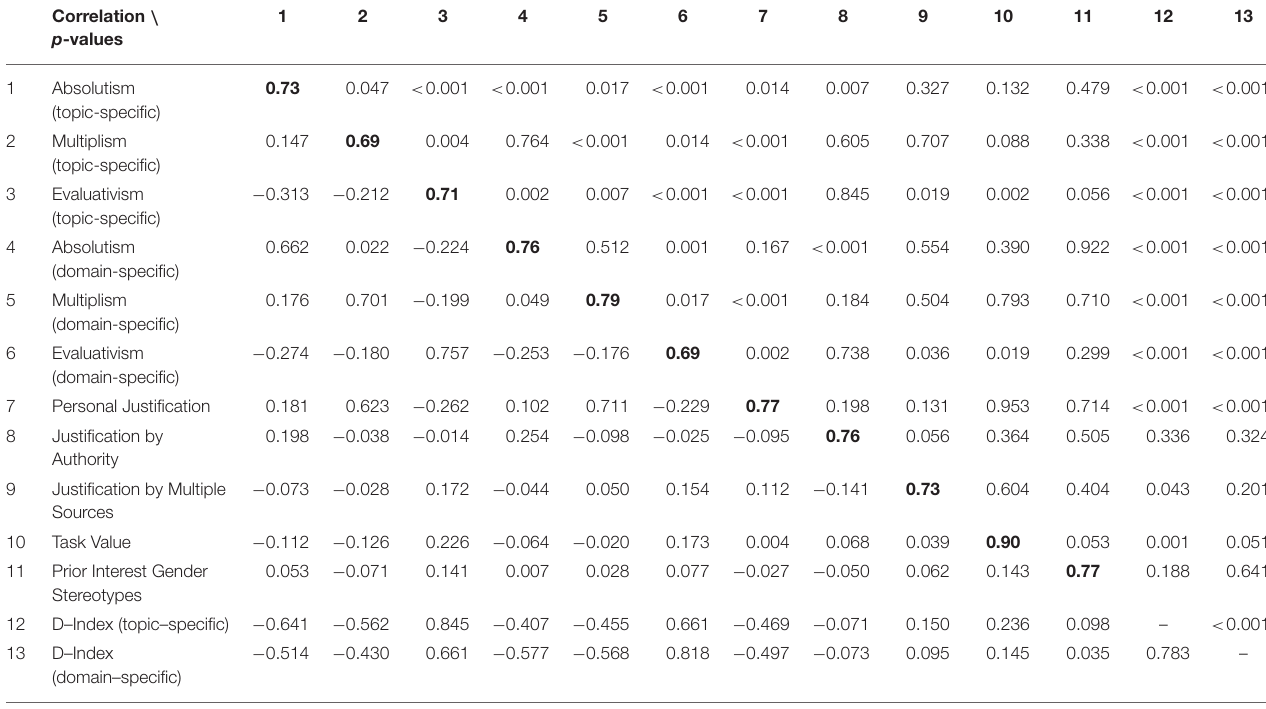
TABLE 2 | Intercorrelations and reliabilities of study variables at the pre-intervention measurement occasion (t1). Correlation \ p